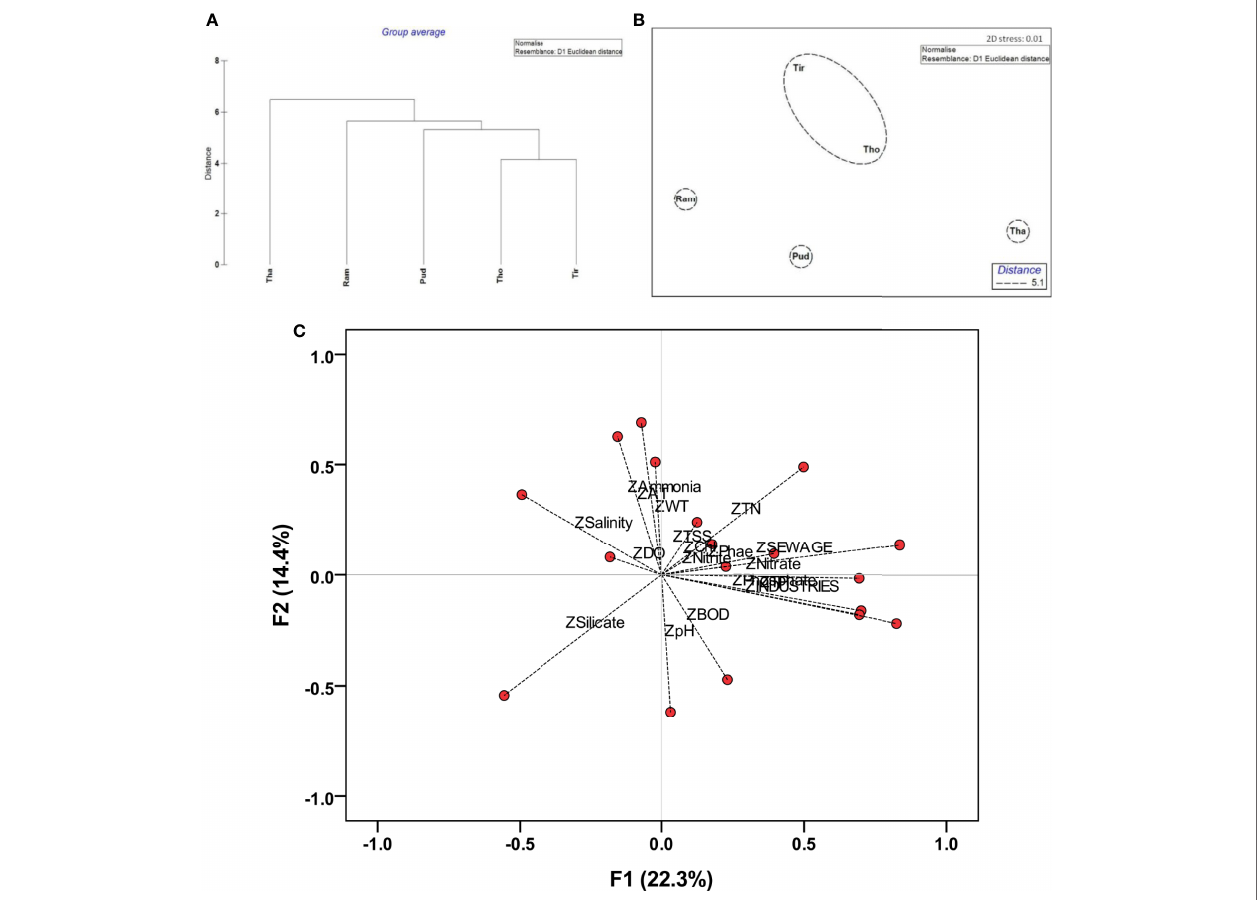
FIGURE 2 | Cluster analysis, 2D NMDS and factor analysis; (A) dendrogram of the physiochemical variables in seawater, (B) non-metric multidimensional scaling resemblance of physiochemical variables in seawater, and (C) factor loading F1 and F2 for environmental